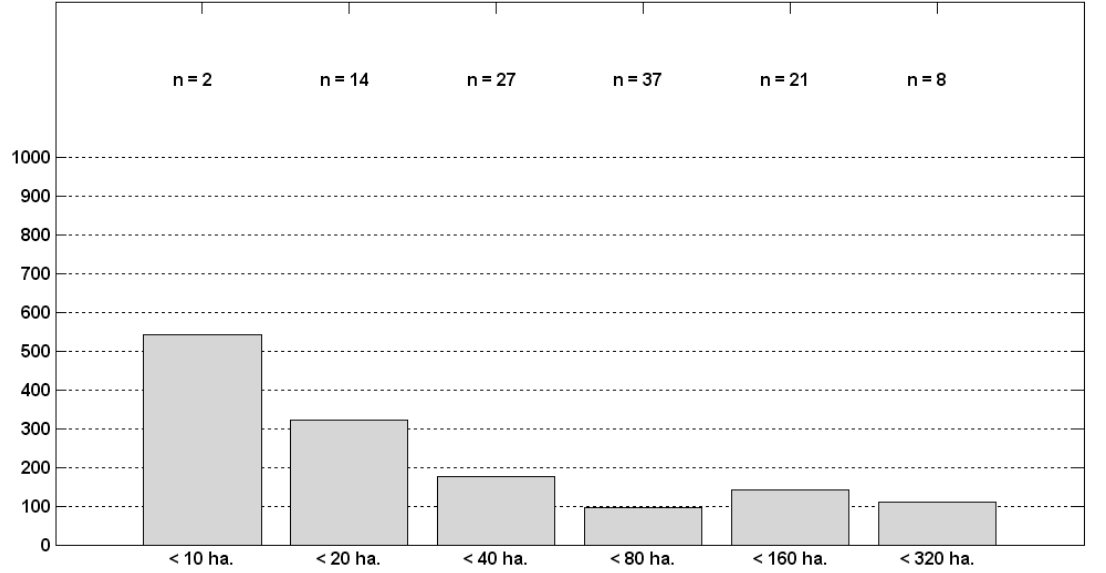
Figure A1.4: General maintenance cost per hectare per year ($R) for properties using some fraction of land to raise cattle. Smaller properties tend also to grow crops, so that the rise in cost for smaller properties is at least partially explained by increased use of fertilizers and pesticides. The n for each bar represents the number of properties of that size in the